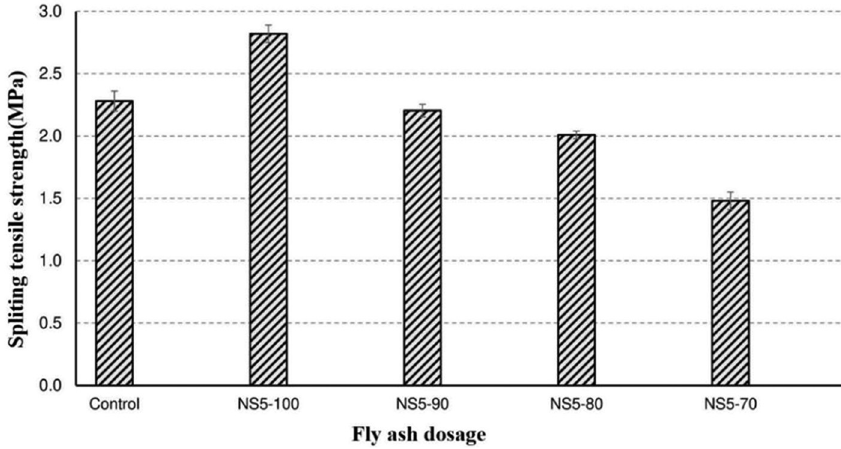
Figure 8: Tensile strength [ 72 ] .